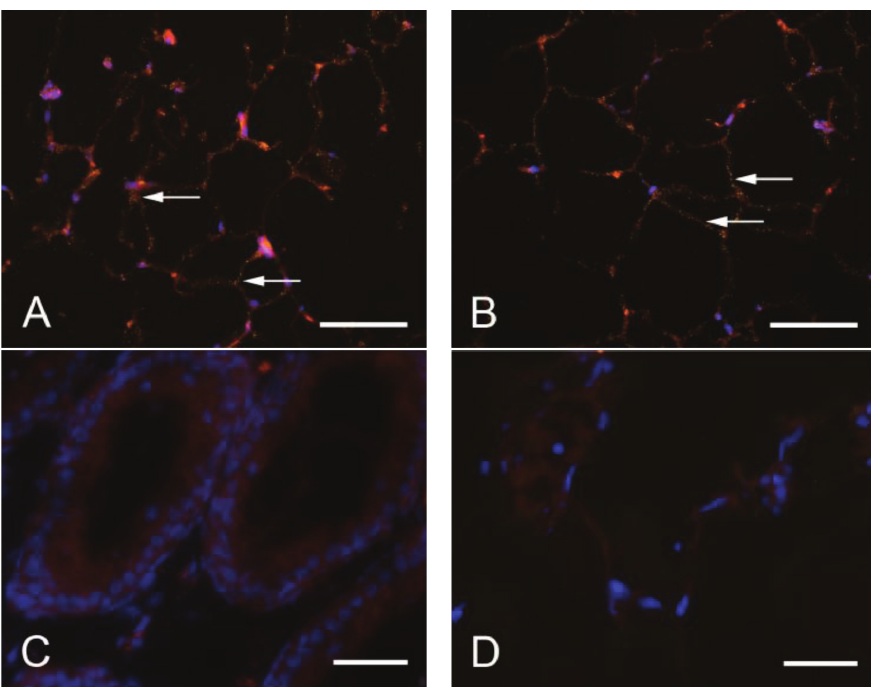
Figure 4: Duolink proximity ligation assay to detect interactions between PTPIP51 and the insulin receptor (IR), respectively PTPIP51 and PKA in standard diet animals. (A) Interaction between PTPIP51 and the IR. (B) Interaction between PTPIP51 and PKA. (C) Negative control, PTPIP51 and the IR in testis, no interaction known. (D) Negative control, DPLA without primary antibodies in adipose tissue. Nuclei are marked by DAPI staining. Arrows: positive reactions. Bars (A, B): 50 𝜇 m. Bars (C, D): 20 𝜇 m.